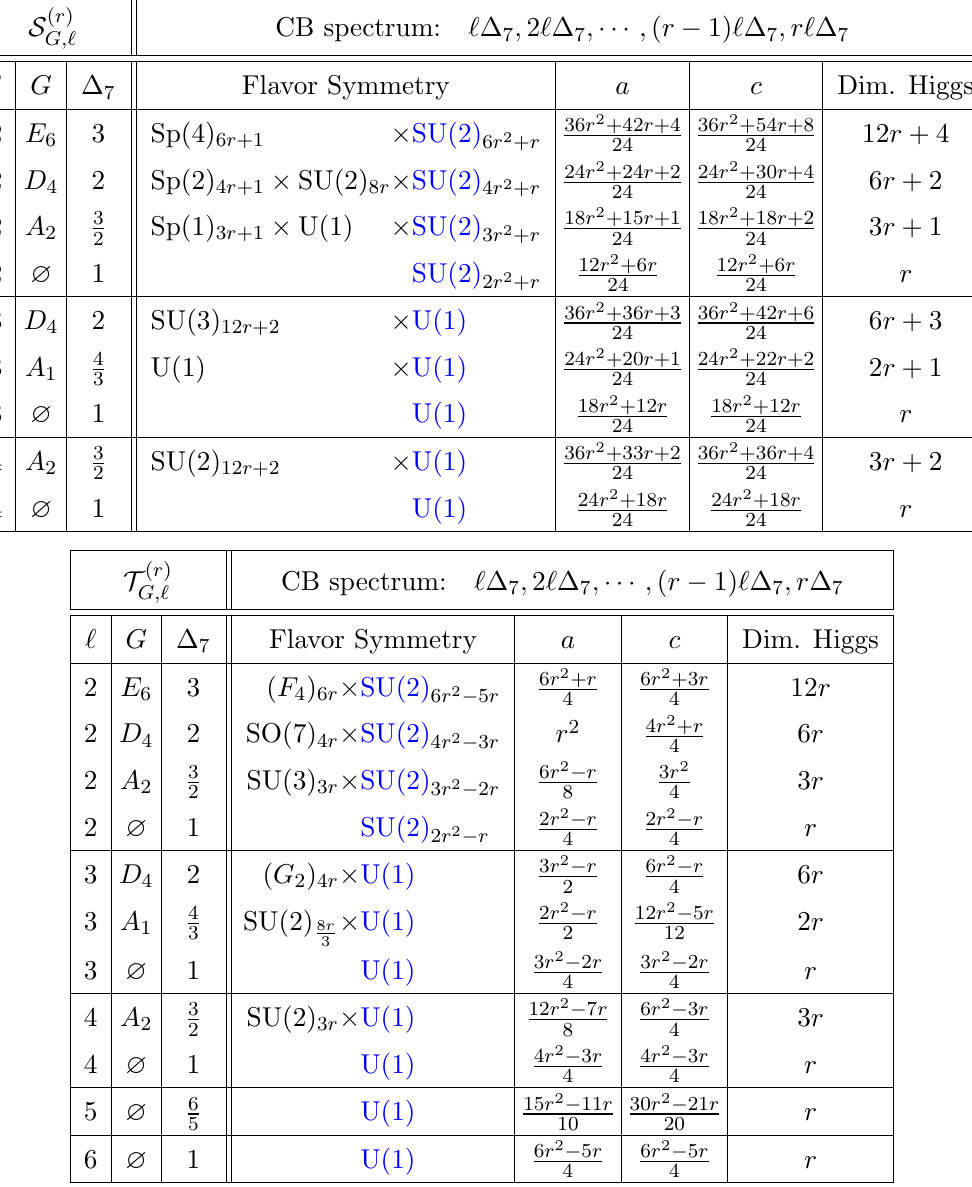
of C 2 = Z . We also listed the conformal central charges a and c , the central charges for ‘ the nonabelian part of the (cid:13)avor symmetry, the dimension of the Higgs branch, and the spectrum of the Coulomb branch operators.